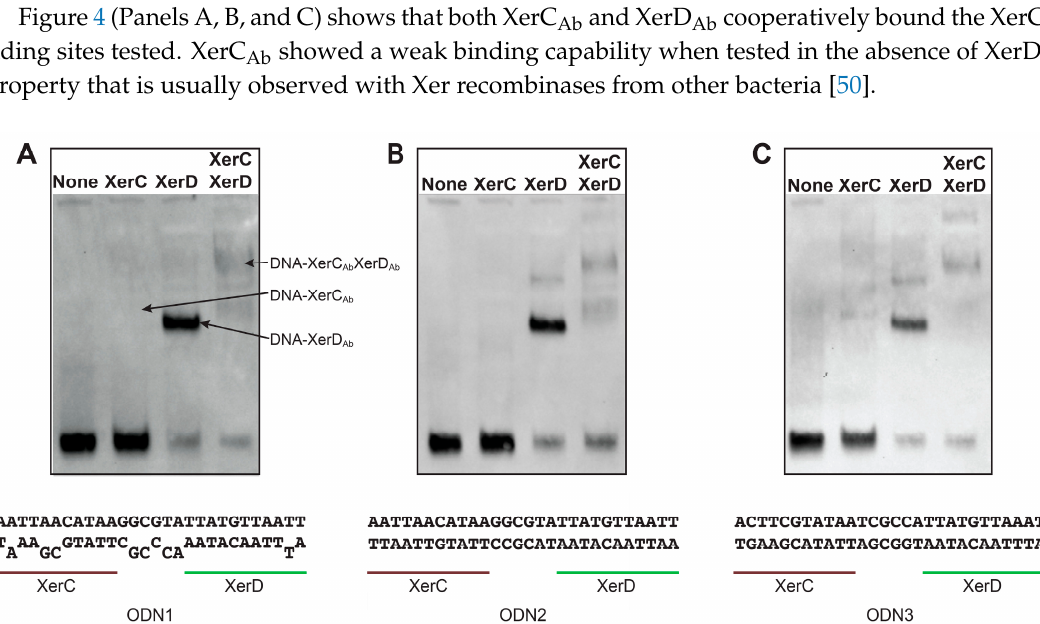
Figure 4. XerC Ab and XerD Ab binding to recombination sites. Labeled oligodeoxynucleotides were incubated in the absence or presence of the proteins indicated at the top. The products were separated by electrophoresis in an 8% polyacrylamide gel and treated as described in Materials and Methods. The nucleotide sequences of the potential Xer recombination sites tested are shown below the gels. ( A ) XerC and XerD binding sites identical to dif and numerous A. baumannii plasmids. ( B , C ) Matched and mismatched sites from the progenitor black molecule, respectively (see Figure